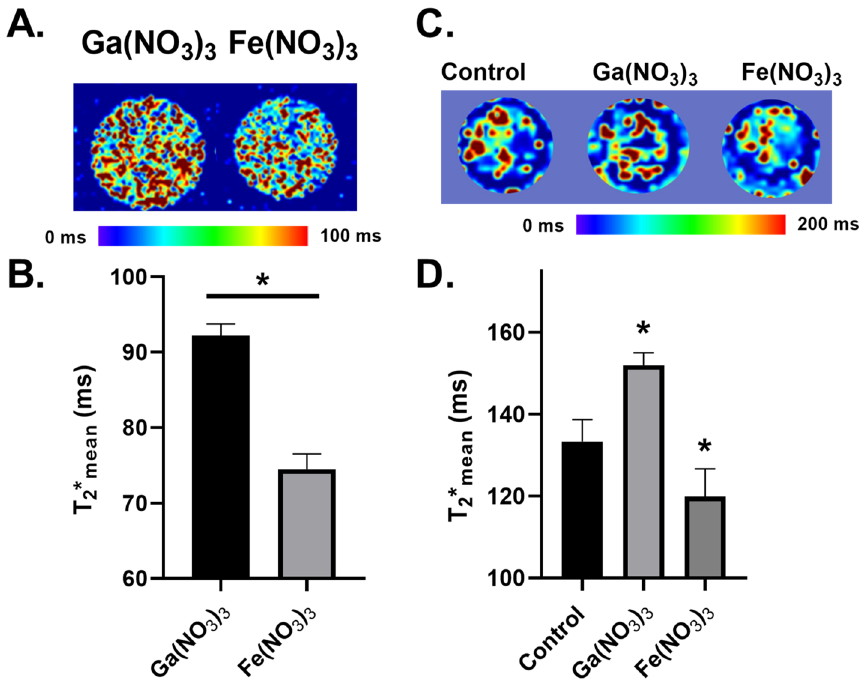
Figure 3. T2* relaxation differentiates between Ga 3+ and Fe 3+ . ( A ) 100 µM Ga(NO 3 ) 3 and Fe(NO 3 ) 3 solutions embedded in a 1% agarose gel in 4 mm O.D. quartz EPR tubes and scanned using a 7 T magnet to generate T 2 * maps. ( B ) Mean T 2 * relaxation times quantified using Slicer3D software by generating a 1 mm ROI for each phantom and calculating the mean T 2 * relaxation time using the data quantification package within the software. *p < 0.05 using a paired t-test. Error bars represent SEM of three replicates. ( C ) Representative T 2 * map of U251 glioblastoma cell pellets following a 3 h treatment of 120 µM Ga(NO 3 ) 3 or Fe(NO 3 ) 3 . ( D ) Mean T 2